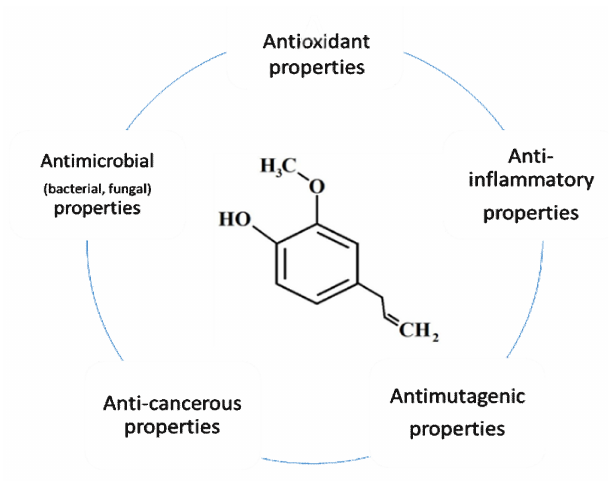
Figure 2. General applications of